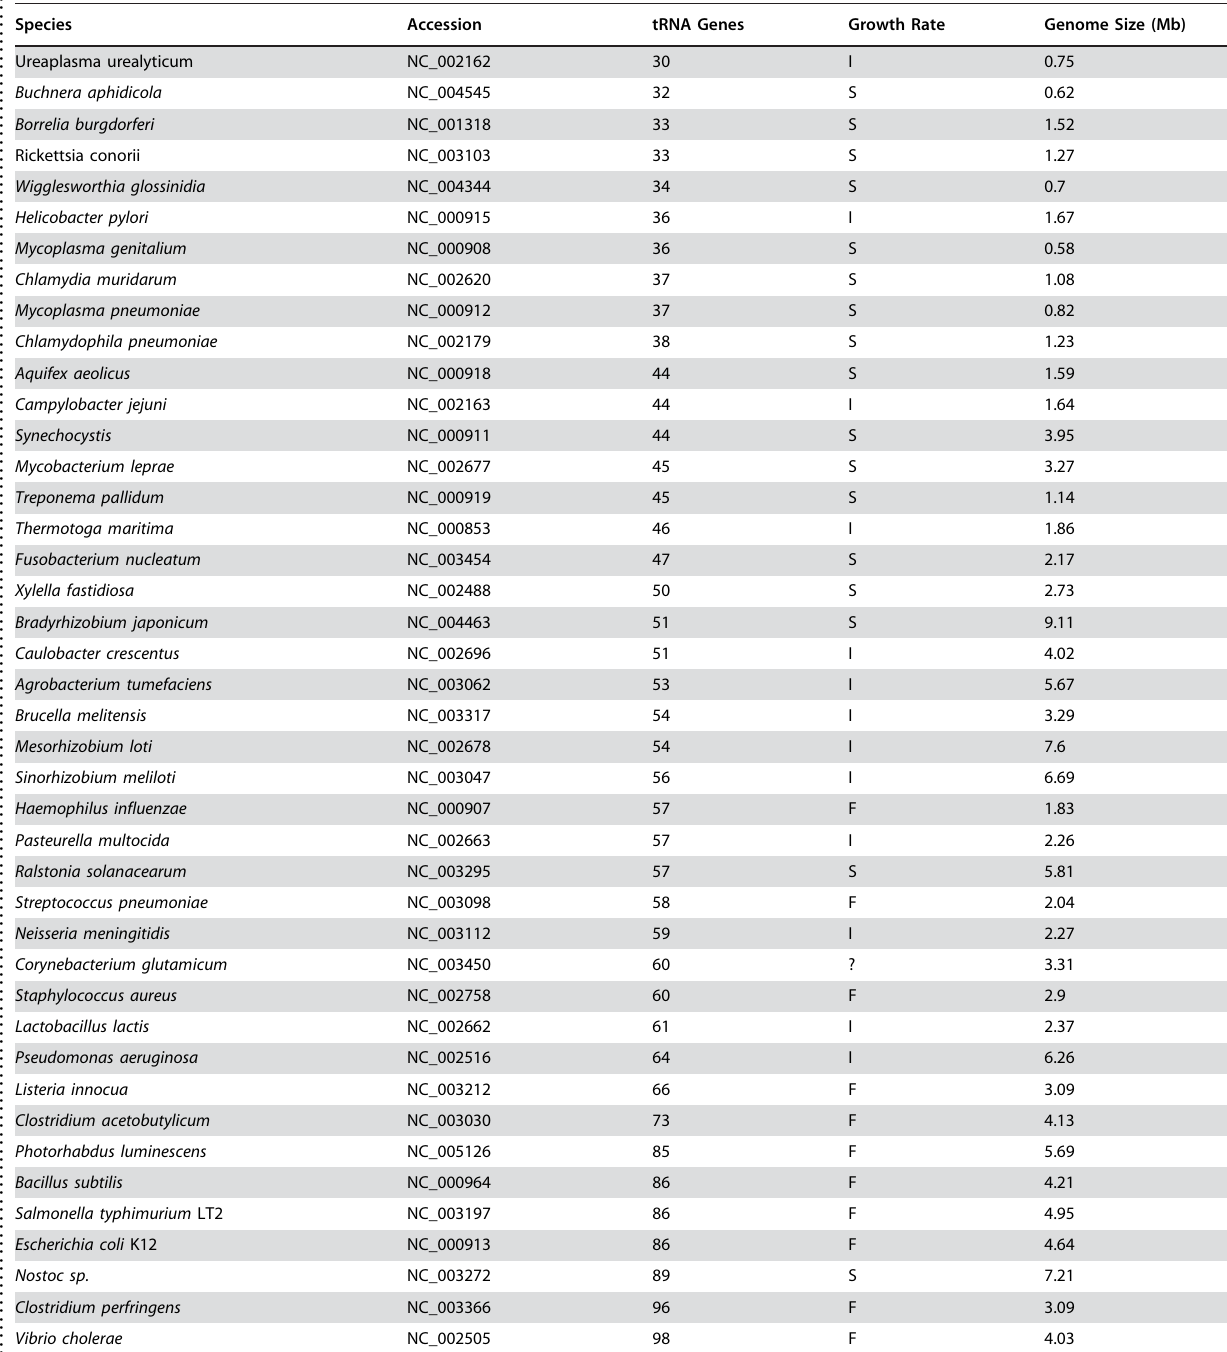
Table 1. Bacterial species analyzed and their general features. .. ... .... ... ... .... ... ... .... ... ... .... ... ... .... ... ... .... ... ... .... ... ... .... ... ... .... ... ... .... ... ... .... ... ... .... ... ... .... ... ... .... ... ...